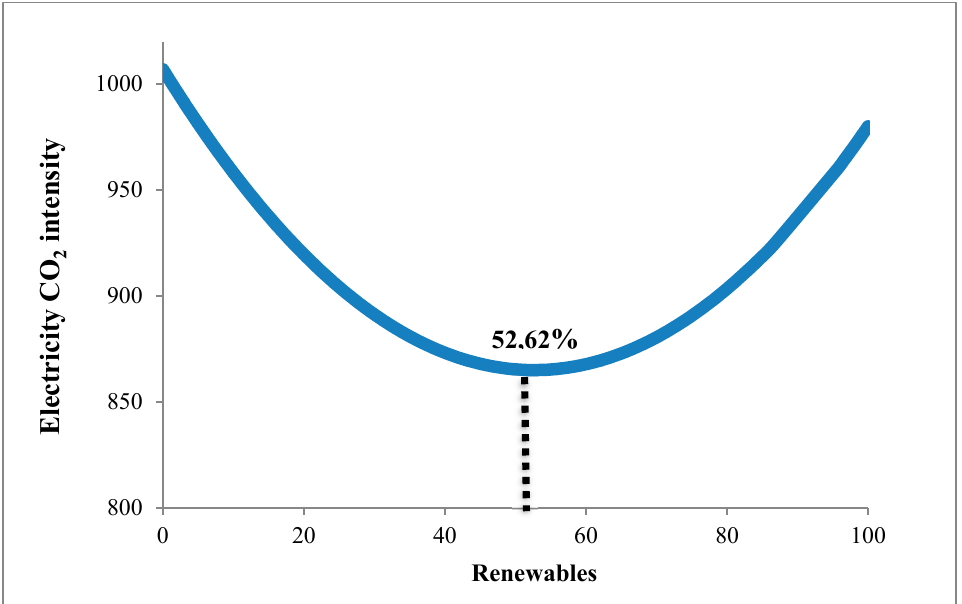
Figure 3. Electricity CO 2 intensity vs. polynomial function of GDP per capita.